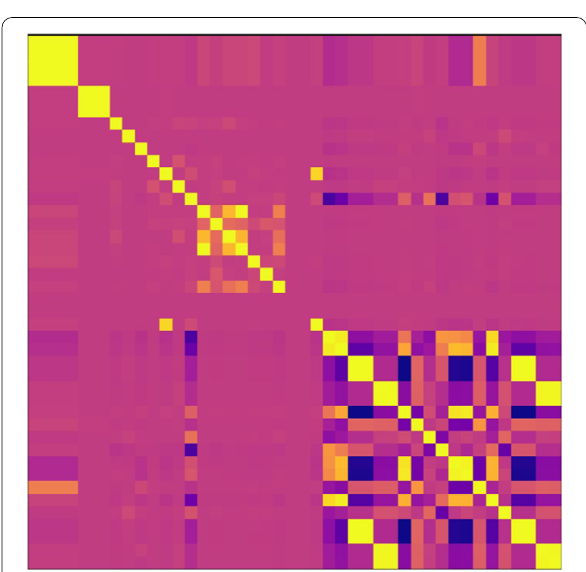
Fig. 7 Heat map of CIC-IDS-2017 feature